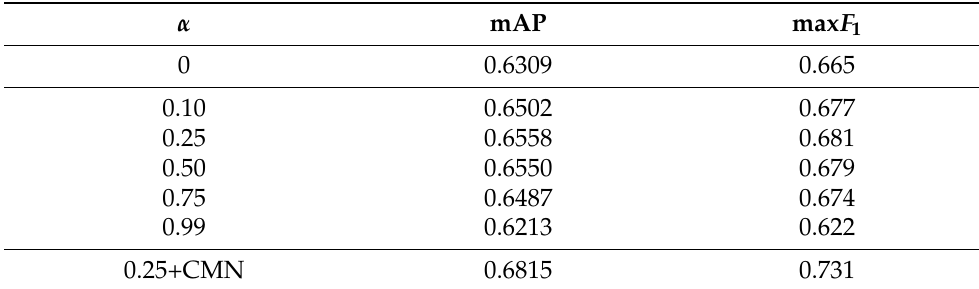
Table 2. Varying α in loss function.